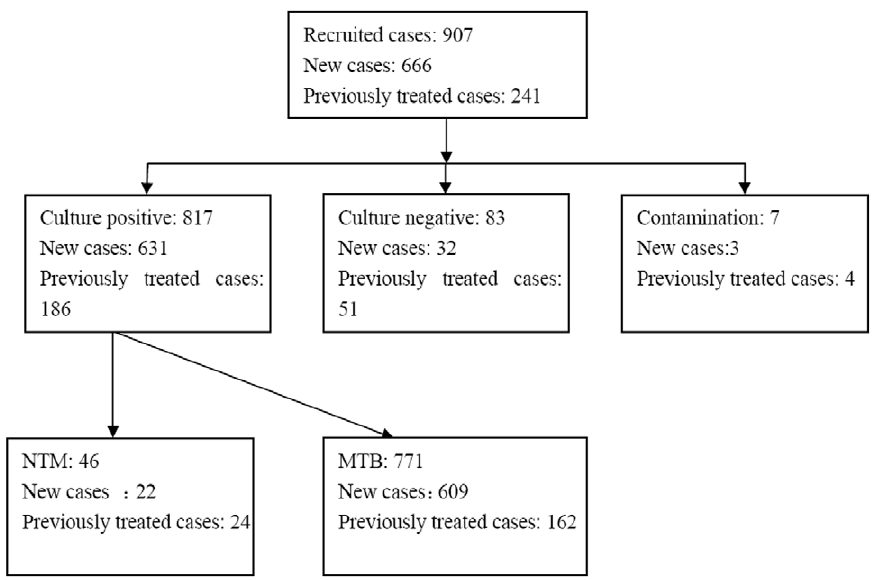
Figure 1. Flow chart of Mycobacterium tuberculosis complex screening.